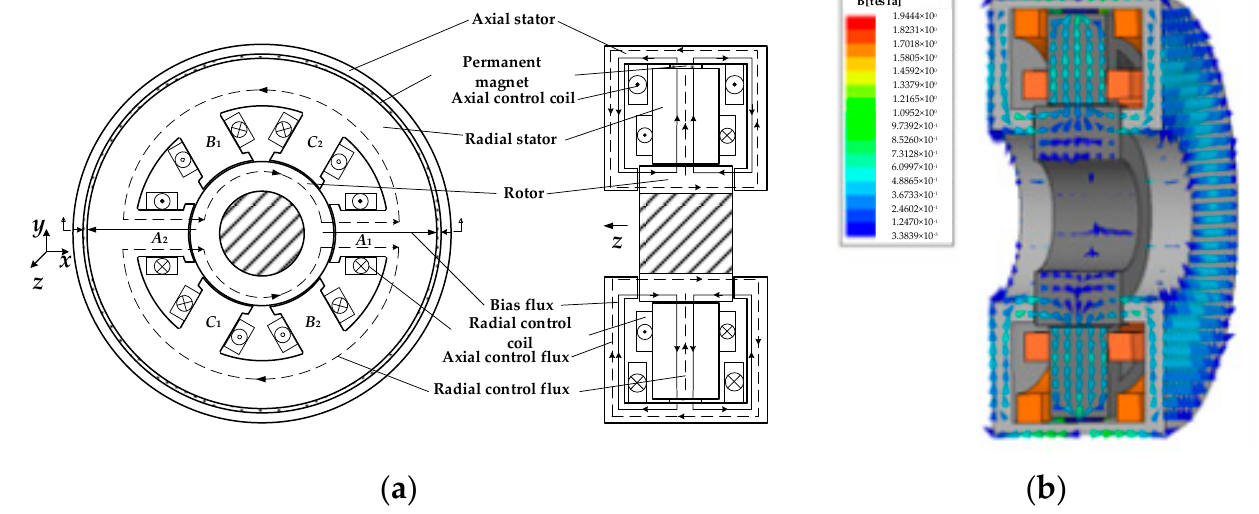
Figure 2. Structure and flux paths of six-pole RAHMB. ( a ) Structure of six-pole RAHMB. ( b ) Vector diagram of flux path in six-pole RAHMB.